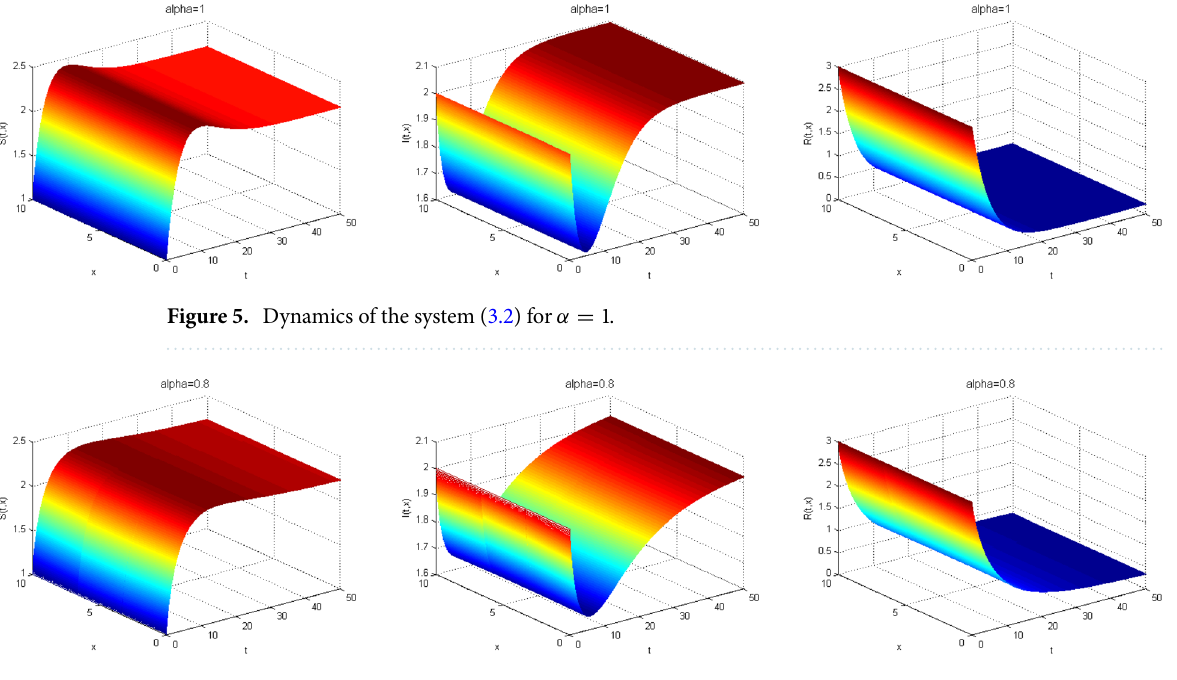
Figure 6. Dynamics of the system (3.2) for α = 0.8